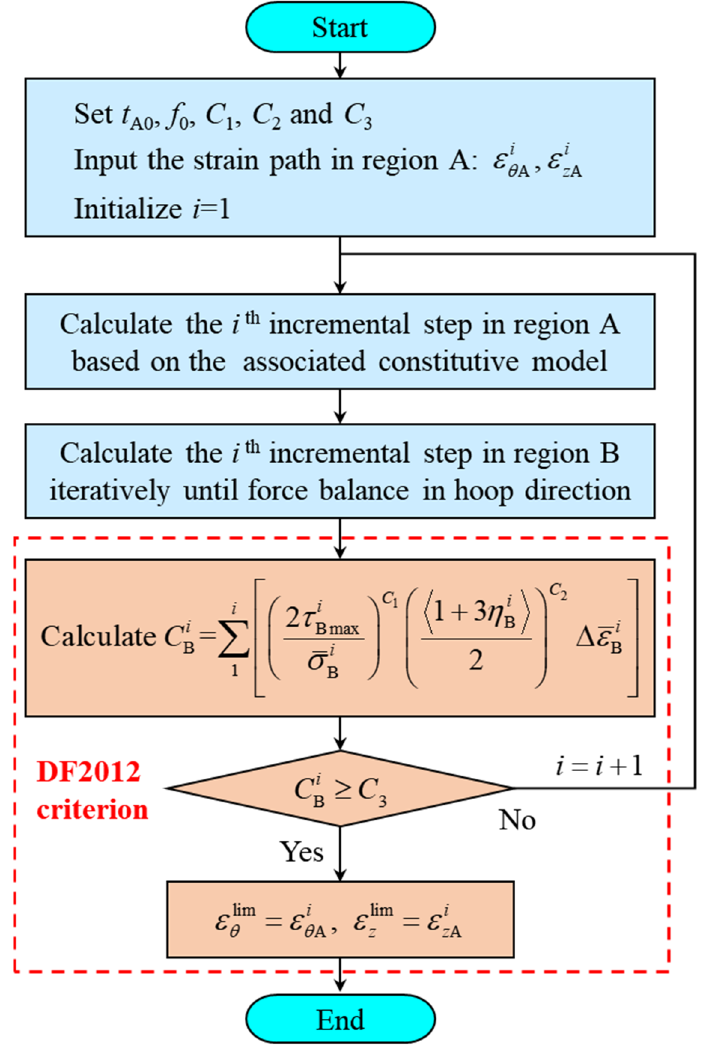
Figure 2. Prediction process for the limit strain under a nonlinear loading path using the M-K+DF2012 model.